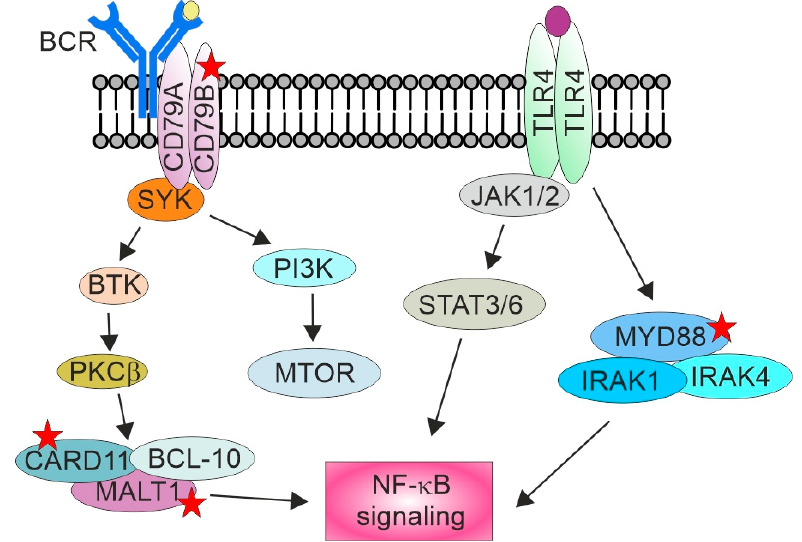
Figure 1. Dysregulated NF- κ B signaling in T-DLBCL. Genomic alterations in the BCR and TLR signaling result in constitutive activation of NF- κ B signaling. Aberrations typical for T-DLBCL are marked with red stars. BTK, Bruton’s tyrosine kinase; IRAK, interleukin-1 receptor-associated kinases; JAK, Janus kinase; MALT1, mucosa-associated lymphoid tissue; MTOR, mammalian target of rapamycin; PI3K, phosphoinositide 3-kinase; PKC β , protein kinase C beta; STAT, signal transducer and activator of transcription; SYK: spleen-associated tyrosine kinase; TLR, toll-like receptor. Adapted from King et al., 2021 [88].